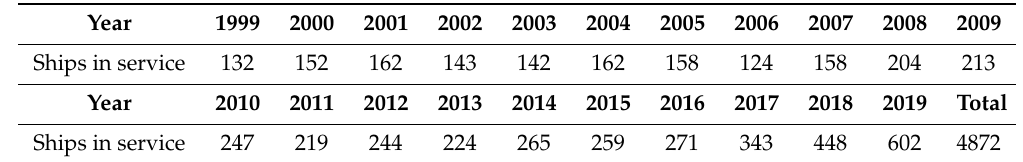
Table 11. Number of passenger ships in service vs. year.